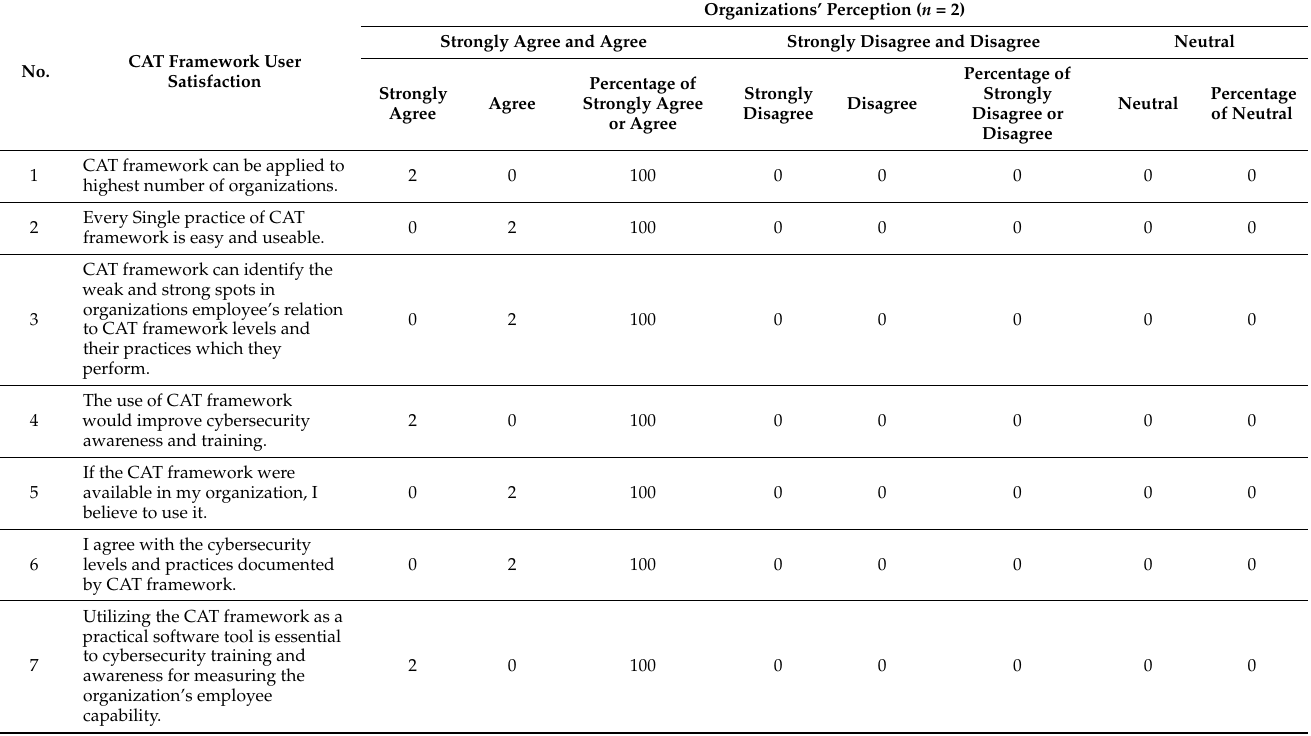
Table 4. CAT framework user satisfaction evaluation from both organization I and organization